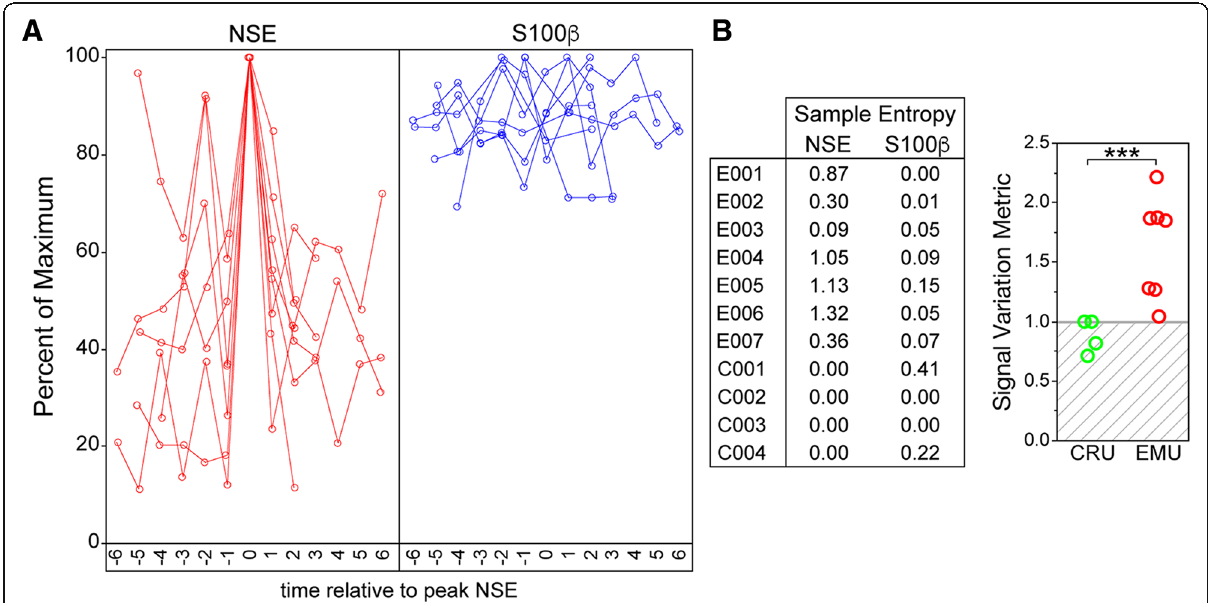
Fig. 4 NSE levels exhibit high sample entropy and large signal variation in epilepsy patients but not healthy controls. a NSE (red lines) and S100 β (blue lines) measurements were converted to percent of maximum for each individual. The time at which the peak NSE value (100%) was measured in each subject was defined as t = 0 and the remaining measurements were plotted relative to this timepoint. S100 β measurements were aligned based on the t = 0 set for NSE. While the NSE measurements exhibit a clear spike phenotype centered on t = 0, the S100 β values show no pattern, indicating that the high signal variability in NSE is not the result of non-specific serum changes. b Sample entropy was calculated for NSE and S100 β measurements in each subject. Most of the EMU patients exhibited high sample entropy (> 0.5) while all of the CRU subjects had zero entropy in the NSE measurements. All S100 β measurements showed low sample entropy. To further reduce the measurements to a single metric, the signal variation was calculated for each individual. Signal variations less than or equal to 1.0 indicate either no variability in the NSE measurements or variability present in both the NSE and S100 β values. All of the CRU subjects had signal variation metrics below 1.0; all of the EMU patients had signal variations above 1.0, with E001, E004, E005, and E006 showing high signal